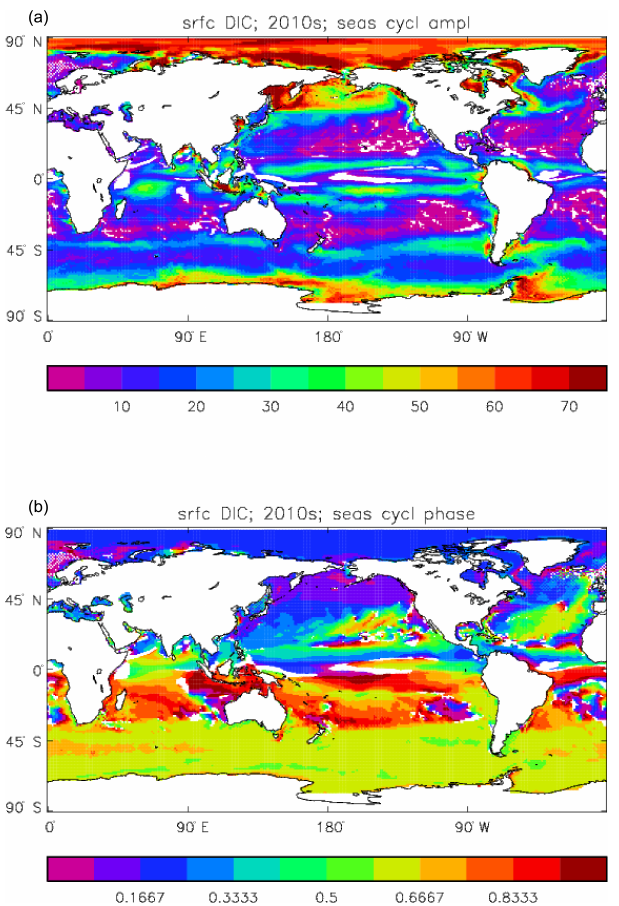
Figure 11. Surface DIC model seasonal cycle, averaged over model years 2010–2019: (a) amplitude of the cycle (mMolCm − 3 ); (b) phase of the cycle (fraction of year). Only points for which the residual variance is less than half the original are shown.